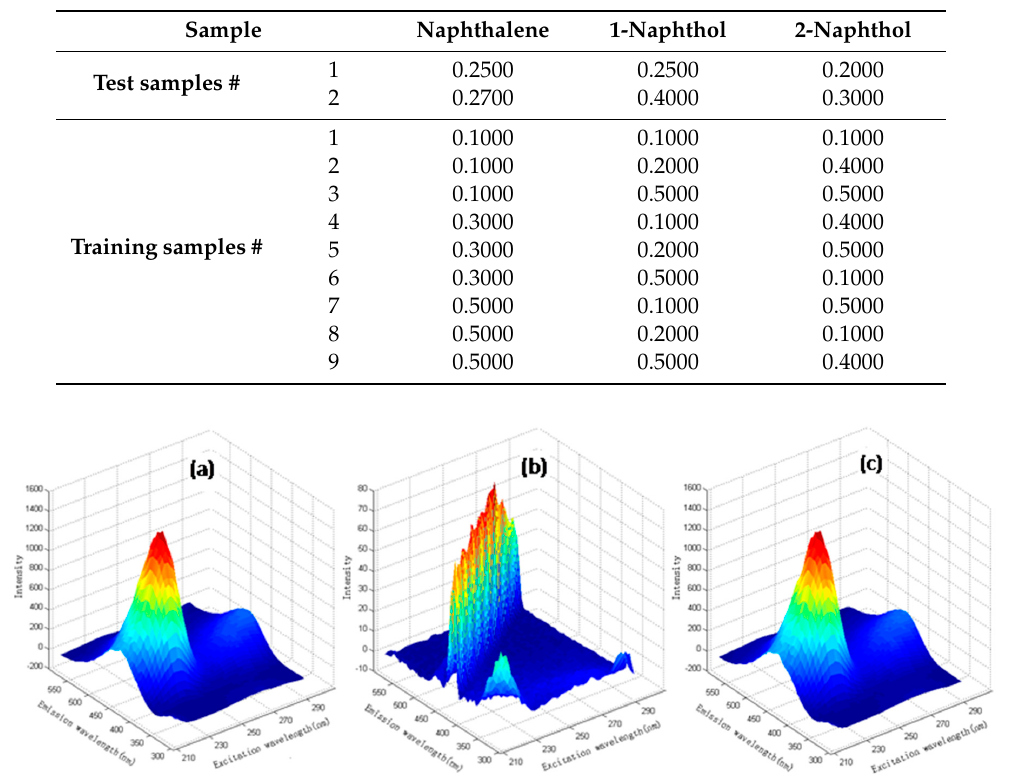
Figure 2. The EEM fluorescence spectra of naphthalene. ( a ) The raw EEM of the naphthalene. ( b ) The mean EEM of the 11 blank samples. ( c ) The EEM subtracted by mean EEM of blank samples.